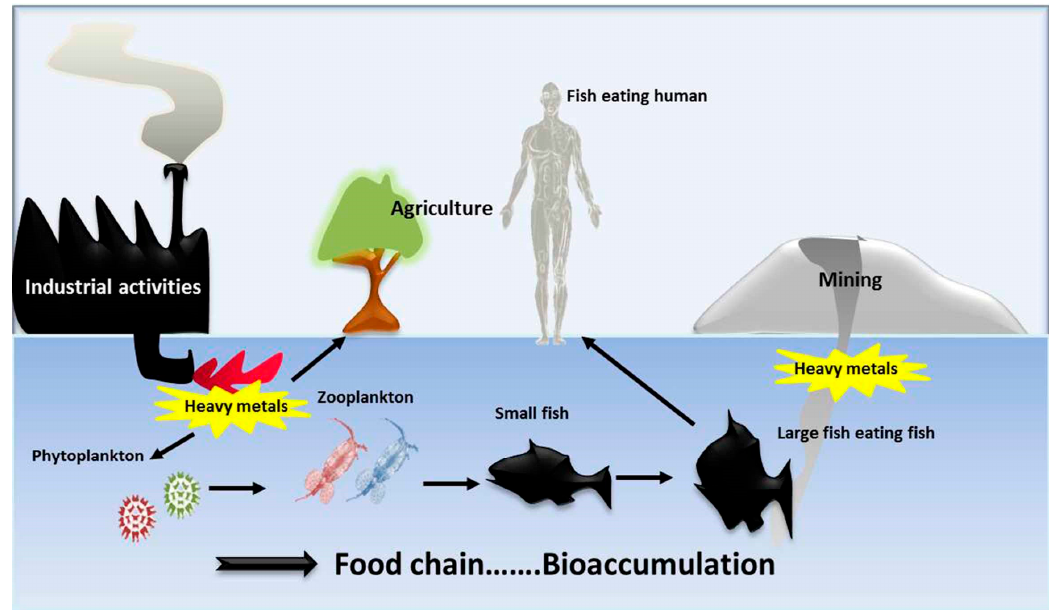
Figure 1. The bioaccumulation of heavy metals due to mining and industrial activities, and its effect on the aquatic food